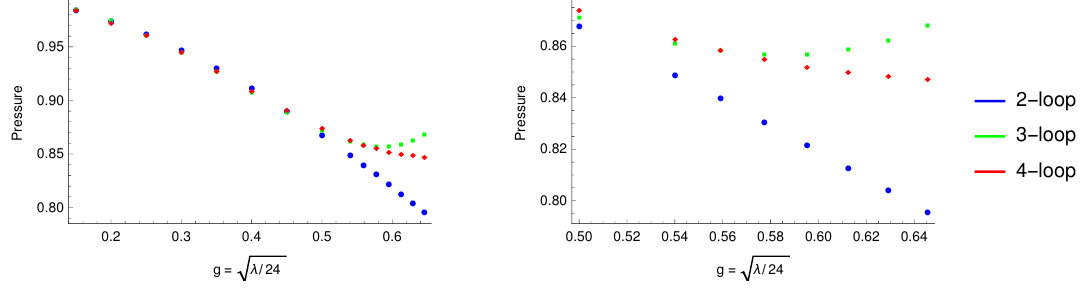
Figure 2. The pressure as a function of coupling. The right panel shows a close up of the large coupling region where the three approximations start to diverge from each